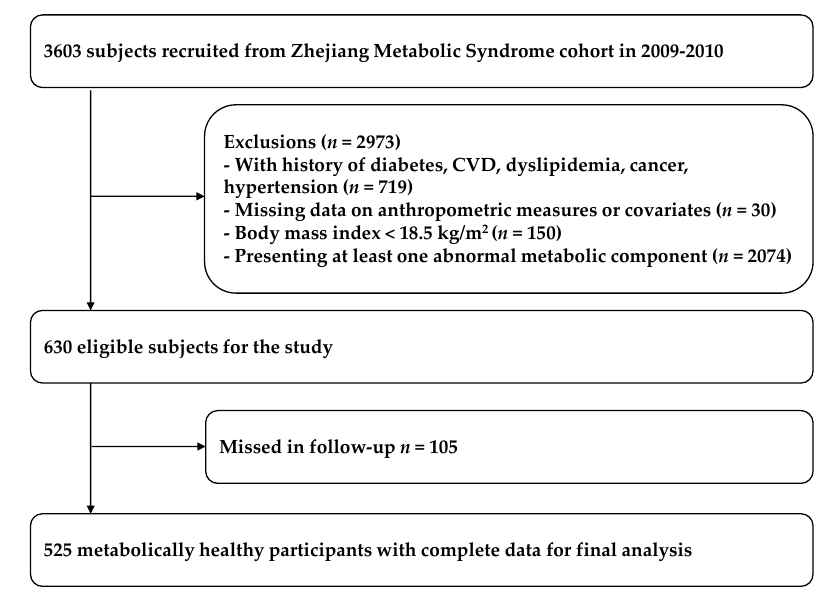
Figure 1. The flowchart of including subjects in the analysis.